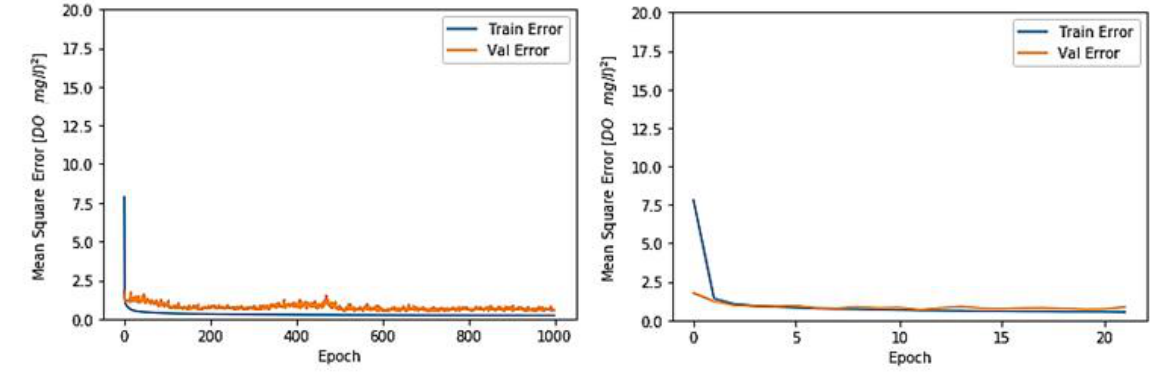
Figure 4 . Mean square error (Toichio station, structure 7-64-64-1).